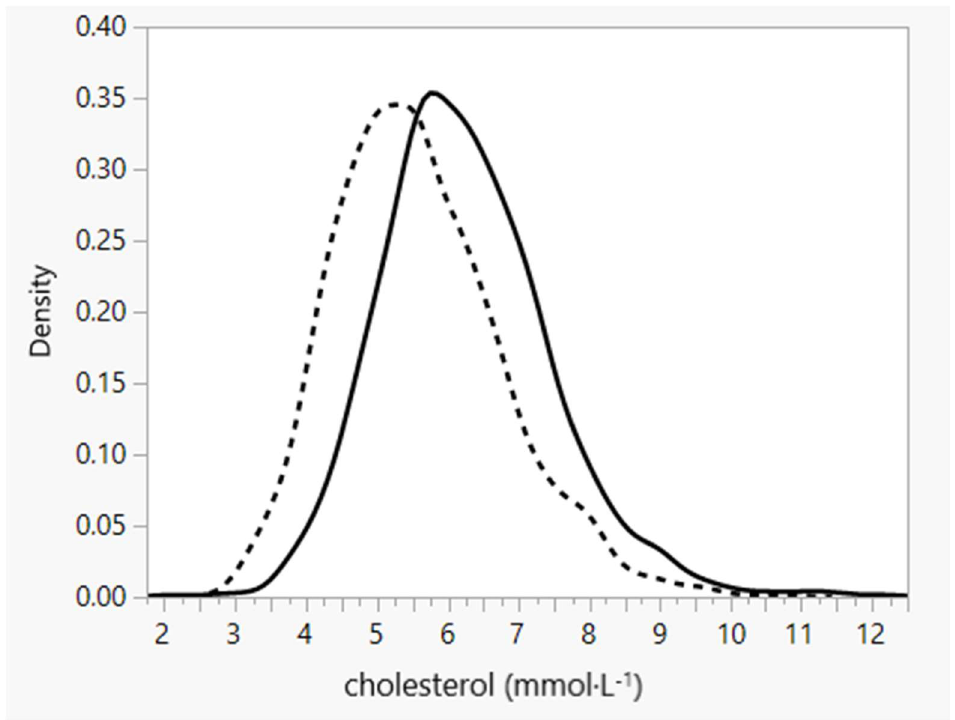
Figure 2. Distribution of total cholesterol levels in a 1% random population sample in 6 districts of the Czech Republic in 1988 ( n = 2988—solid line) and 1992 ( n = 2763—dashed line).